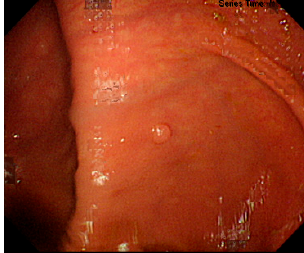
Figure 16. Unobvious polyp textures. Figure 17. polyp image size below 1800 pixels. In this study, we employed a deep learning framework for colorectal polyp detection by using grayscale images. The marked polyp data in the public database of the CVC Clinic and the clinical data provided by the Chang Gung Medical Hospital were collected for verification and testing. Rather than only using an analytic method for single-source